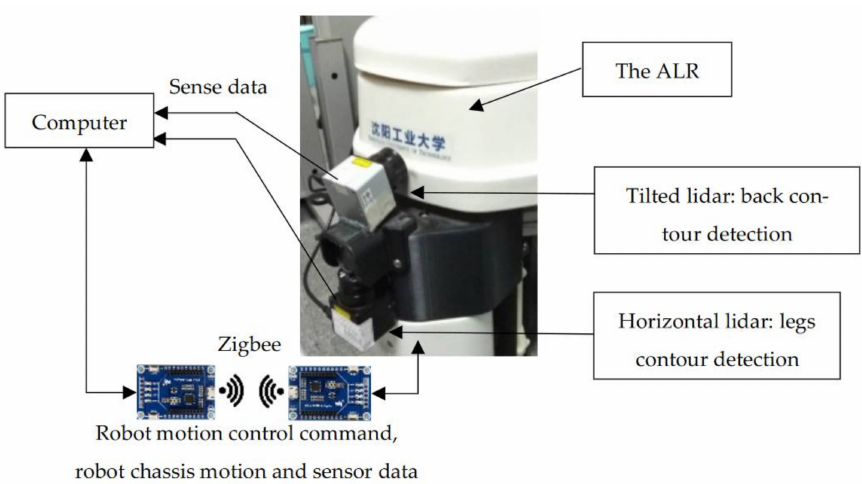
Figure 3. The dynamic intention recognition